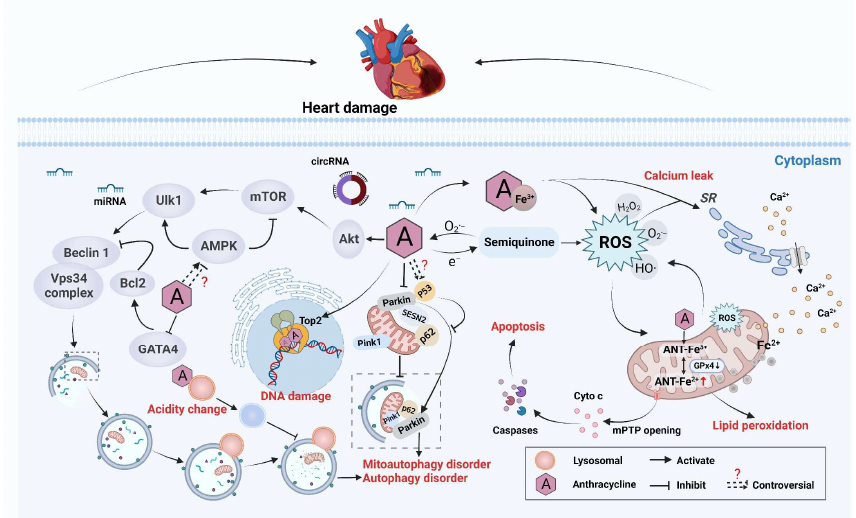
Figure 1. ANTs cause cardiotoxicity through multiple mechanisms. ANTs induce ROS production: a large number of ROS causes mitochondrial swelling, opens the mPTP, and activates endogenous apoptotic pathways. ANTs cause mitochondrial lipid peroxidation by downregulating GPx4 expres- sion. ANTs cause dysregulation of macroautophagy and mitophagy and affect autophagy-lysosomal acidity. ANTs targeting Top2 leads to DNA damage. ANTs induce Ca 2+ leakage in the sarcoplasmic reticulum. ANTs induce changes in ncRNA expression. ROS, reactive oxygen species;mTOR, mammalian target of rapamycin; Bcl-2, B-cell lymphoma 2; Ulk1, unc-51-like autophagy activating kinase 1; SR, sarcoplasmic reticulum; Top2, topoisomerase 2. Created with BioRen- der.com.